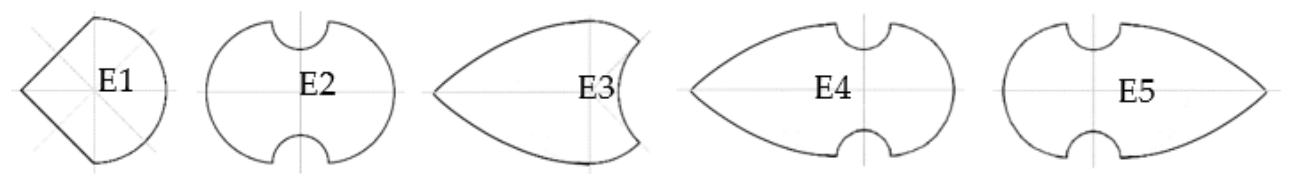
Figure 10. Experimental shapes of vortex shedder bars.